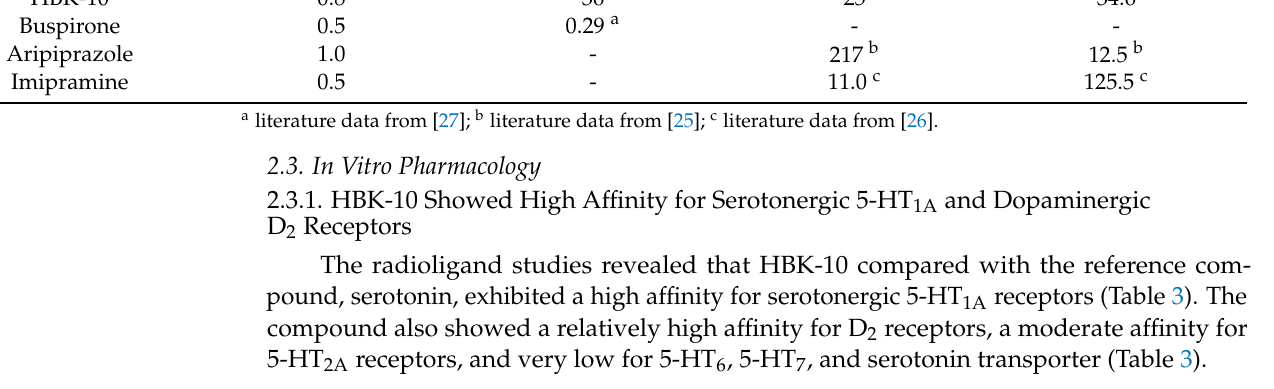
Table 3. The affinity of HBK-10 for serotonergic 5-HT 1A , 5-HT 2A , 5-HT 6 , 5-HT 7 receptors, dopaminergic D 2 receptor, and serotonin